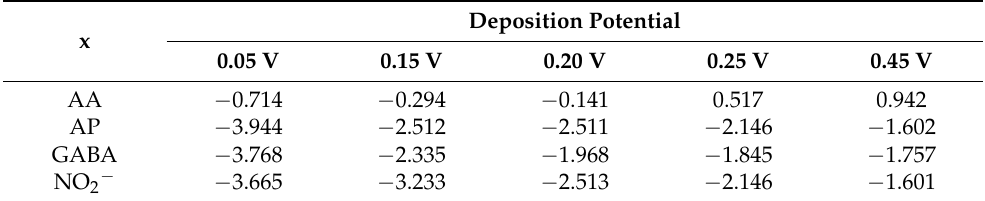
Figure 6. The current sensitivities of Au deposits to CO and AA along with the corresponding ESAs depending on the deposition potential ( n = 5). Table 1. Selectivity coefficients (log K amp ) of the Au electrodes deposited with various deposition CO,x potentials to CO over typical biological interferents